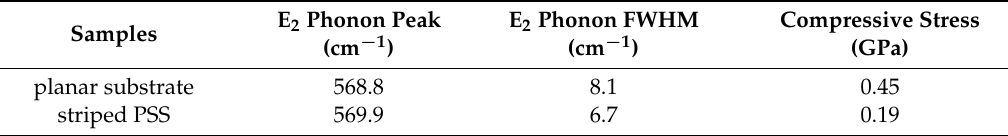
Table 1. Summary of the Raman results recorded from planar substrate and fitted striped PSS (patterned sapphire substrate) samples at room temperature. FWHM (full width at half